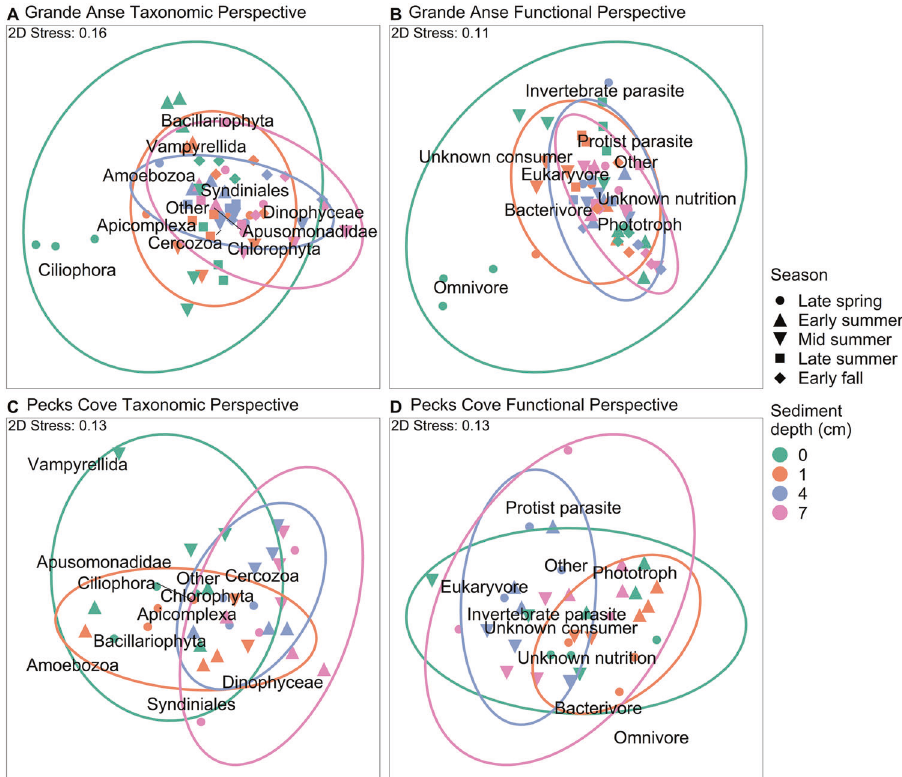
Fig. 2 Non-metric multidimensional scaling (nMDS) graphs showing the relative placements of protist communities (a symbol represents a sample) in ordination space, for Bay of Fundy mud fl ats in 2019. Community dispersion around the centroid for each sediment depth, pooling over seasons, are captured by 95% con fi dence ellipses. Positions of taxa or trophic functional subgroups represent correlations with nMDS axes and indicate directions of increasing magnitude. “ Other ” comprises subgroups “ Mixotroph ” , “ Vertebrate parasite ” , “ Unknown animal parasite ” , “ Plant parasite ” and “ Unknown parasite ” , or taxa with <1% of average protist reads. Panels A and C illustrate the taxonomic perspective at each site, while B and D display the functional perspective. In A and C , the small lines indicate the actual placements of taxa in ordination